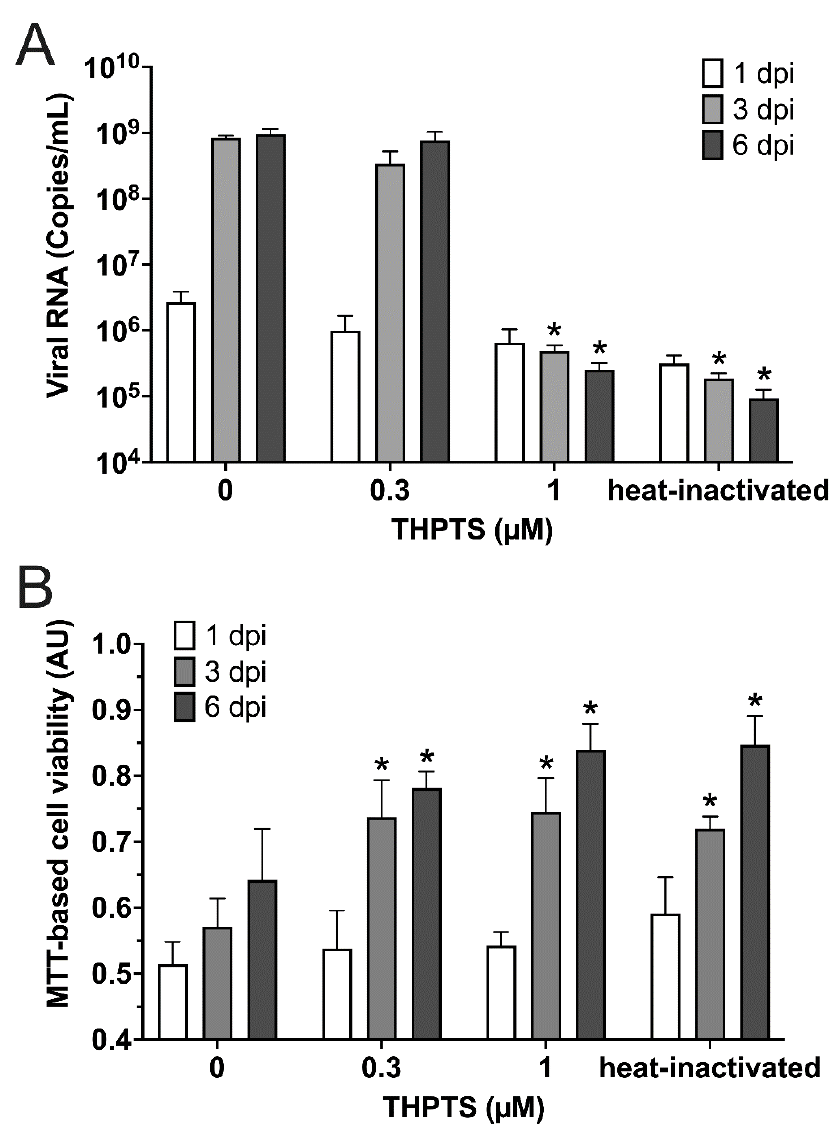
Figure 2. Results from photodynamic inactivation treatment of SARS-CoV-2. ( A ) Viral RNA was detected in supernatants after PDI-treatment for 10 min (light dose 7.8 J/cm 2 ) at different photosensitizer (PS) concentrations or after heat-inactivation and subsequent infection (1/3/6 dpi; n = 4) of Vero cell cultures. ( B ) Cell viability was determined by an MTT-based assay for mitochondrial activity. Data are presented as mean and SD. * p < 0.05 when compared to respective samples treated with 0 µM THPTS.